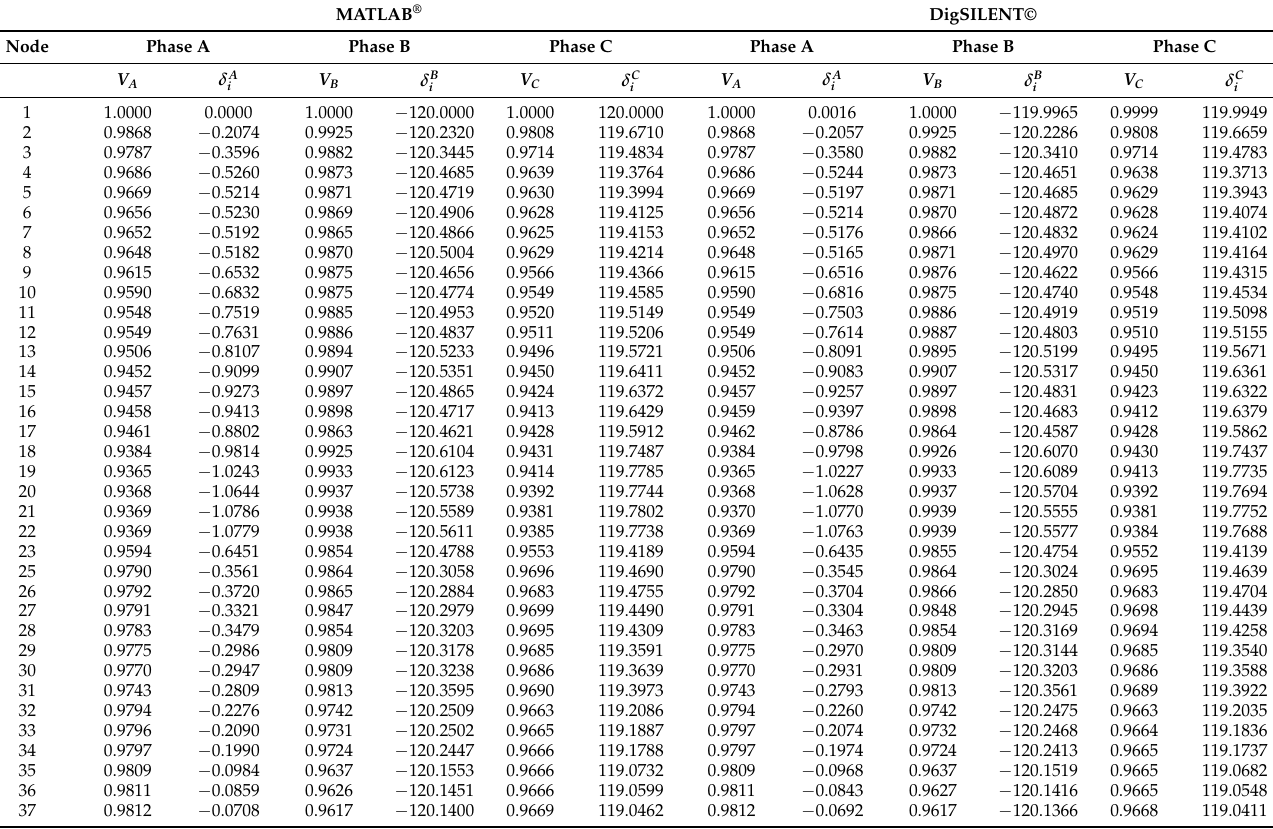
Table 8. Nodal voltage per phase in the IEEE 37-node test system.